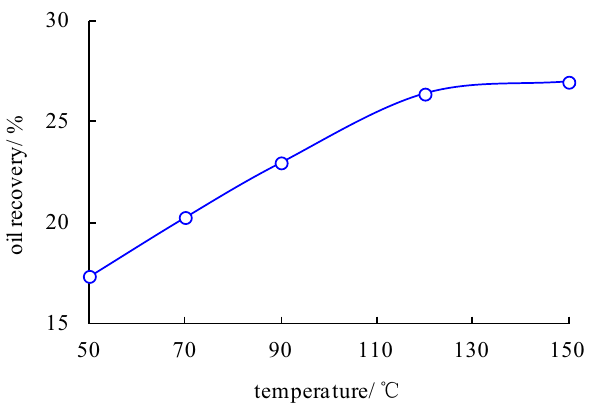
Fig. 4 Comparison of oil recovery at different converting